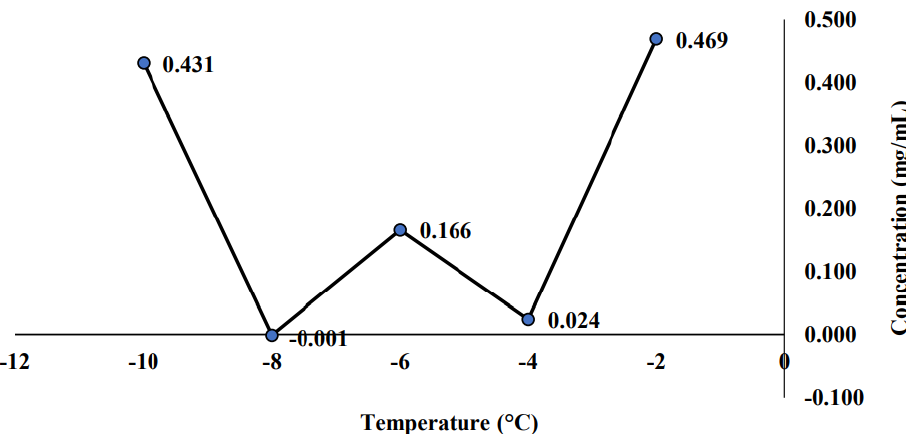
Figure 3. Saponin concentration of non-sterilized sample at different temperatures.